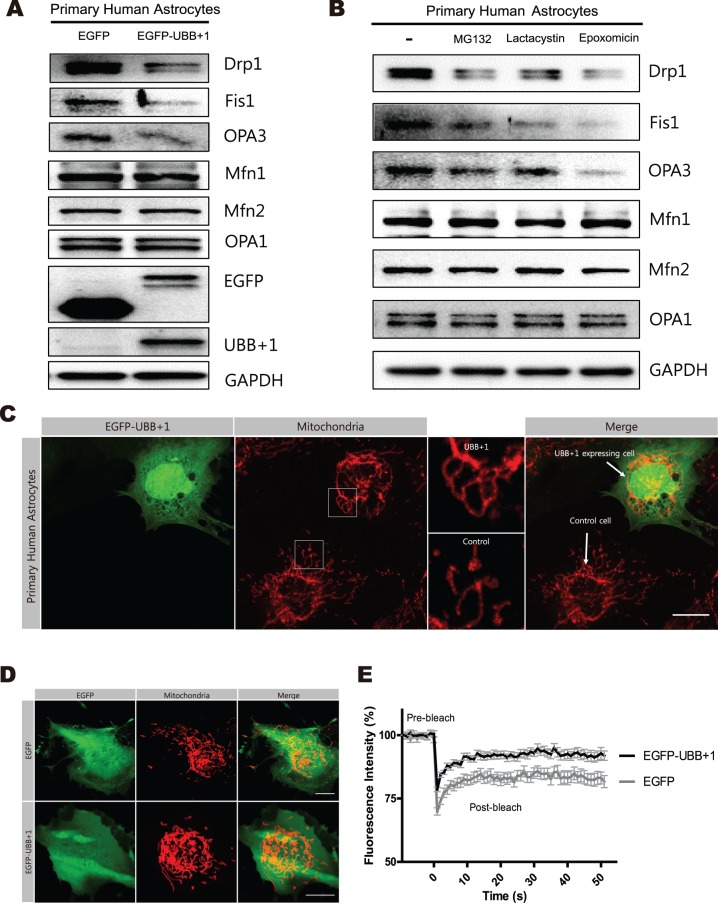
The regulation of mitochondrial dynamics by transient expression of UBB+1 and proteasome inhibition in primary human astrocytes.
A, Astrocytes were transiently transfected with pEGFP or pEGFP-UBB+1. After 72 hrs, cells were lysed and analyzed by Western blotting for mitochondrial proteins (Drp1, Fis1, OPA3, Mfn1, Mfn2, and OPA1), EGFP, and UBB+1. GAPDH was used as a loading control, and all blots are representative of three independent experiments. B, Cells were incubated in the absence or presence of 1 µmol/L MG132, a reversible proteasome inhibitor for 12 h, 1 µmol/L lactacystin, an irreversible proteasome inhibitor, for 12 h, or 1 µmol/L epoxomicin, a highly specific proteasome inhibitor. Cell lysates were analyzed by Western blotting for mitochondrial proteins. C. Mitochondrial morphology was analyzed after staining for Tom20 protein by confocal microscopy in primary human astrocytes after 72 h transiently transfection with pEGFP-UBB+1. A higher magnification views of mitochondrial image in the white square are presented in the each right side of the images. (scale bar = 20 µm). D, E, Primary human astrocytes were co-transfected with pEGFP and mito-DsRed, or pEGFP-UBB+1 and mito-DsRed. After 72 hrs, confocal microscopy was used to analyze the mitochondrial morphology. And the fluorescence intensity recovery rates after photobleaching are plotted. Data are plotted as the mean ± SEM. (n = 15–20 cells for each group).